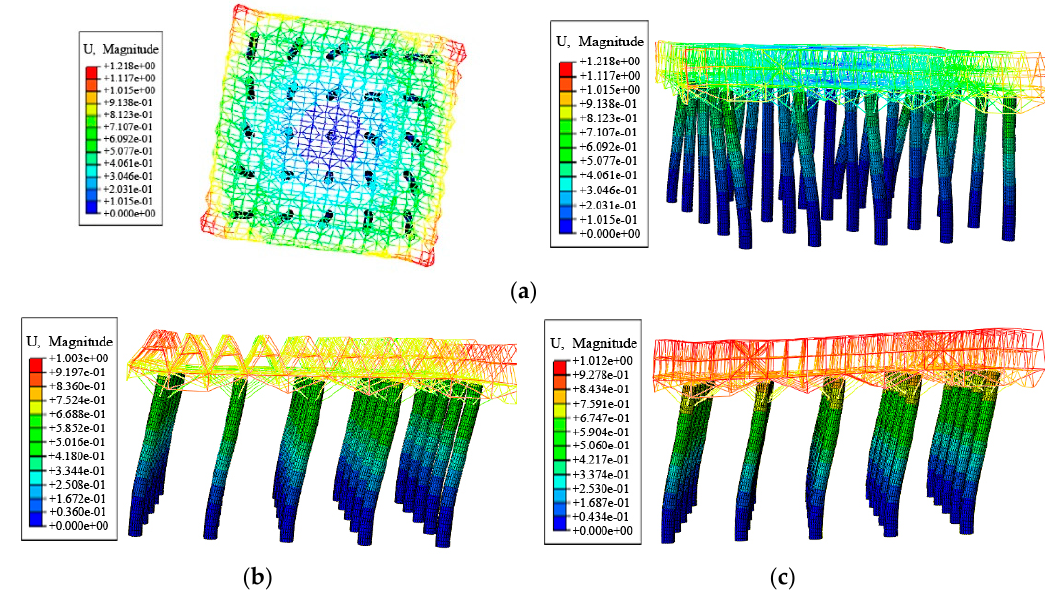
Figure 7. Vibration mode shapes: ( a ) First mode; ( b ) second mode; ( c ) third mode.